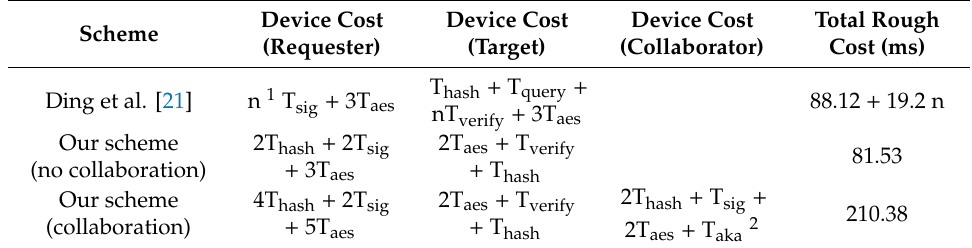
Table 3. Comparison of computational costs for IoT